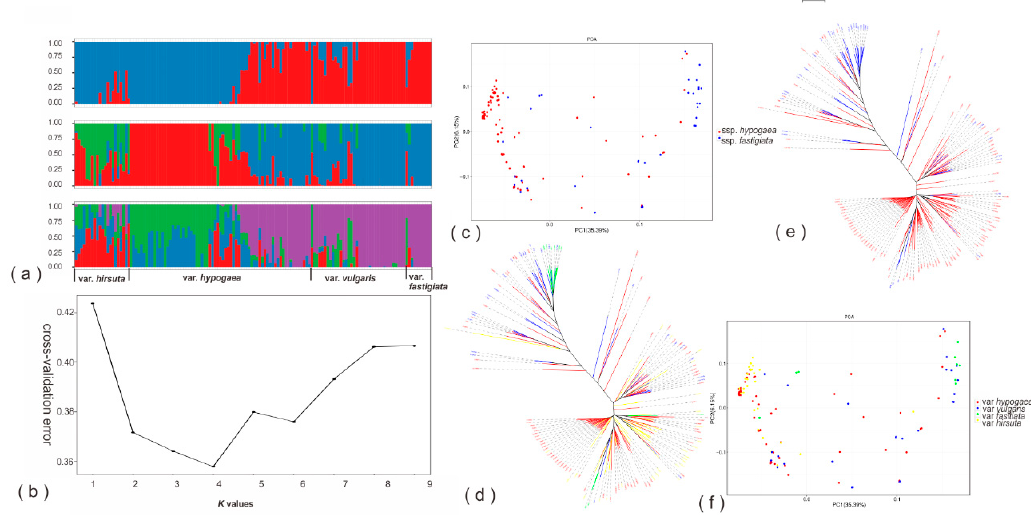
Figure 2. Genetic diversity and population structure of the studied peanut accessions. ( a ) Population structure, each accession is represented by a single vertical line and colors represent ancestries. ( b ) Estimated Ln (probability of the data) calculated for each K ranging from 1 to 9. ( c , f ) Scatter plots of the first two principal components (PCA analyses), each dot represents one accession. ( d , e ) Phylogenetic trees constructed using the neighbor-joining method.